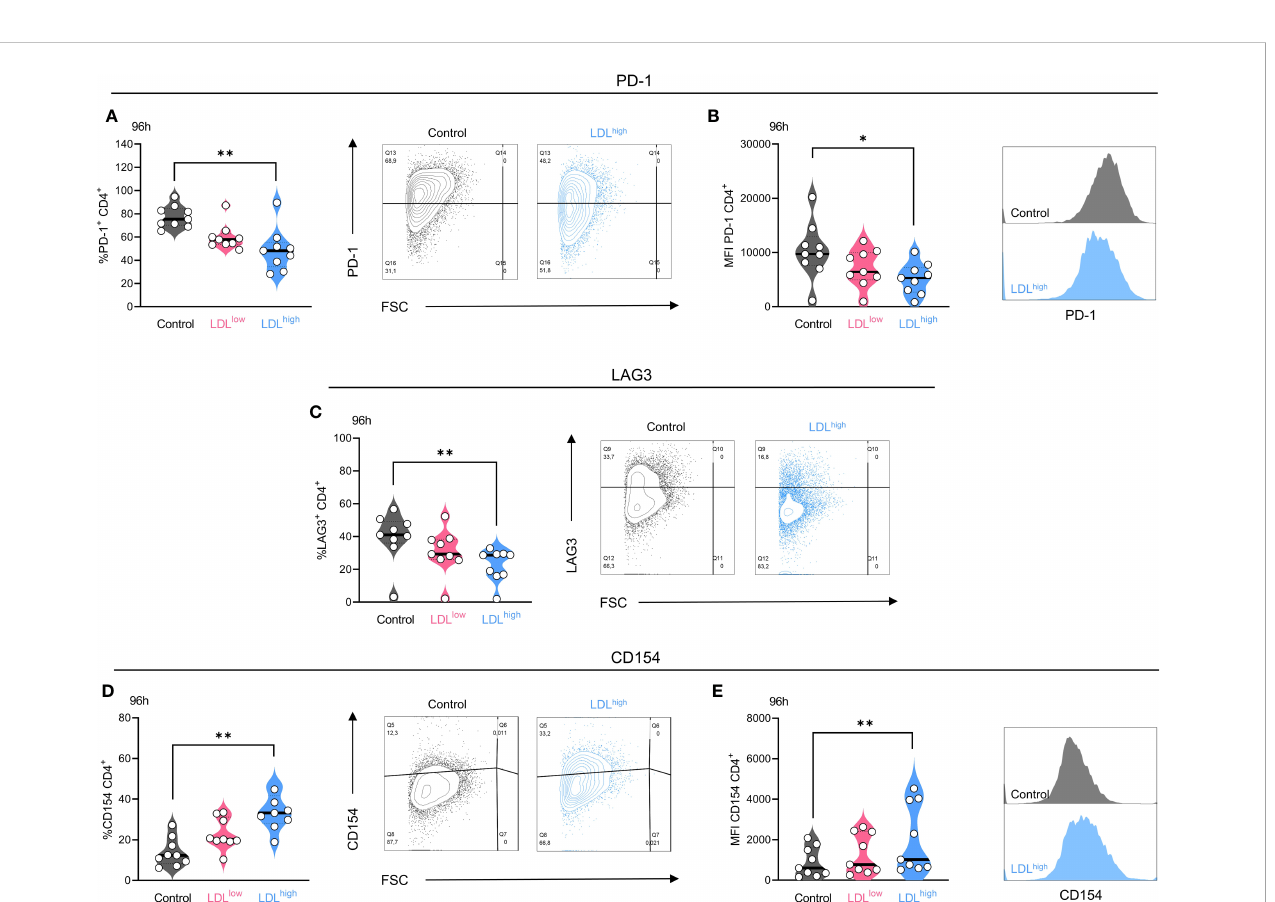
These markers and their functions were considered potentially relevant in the context of